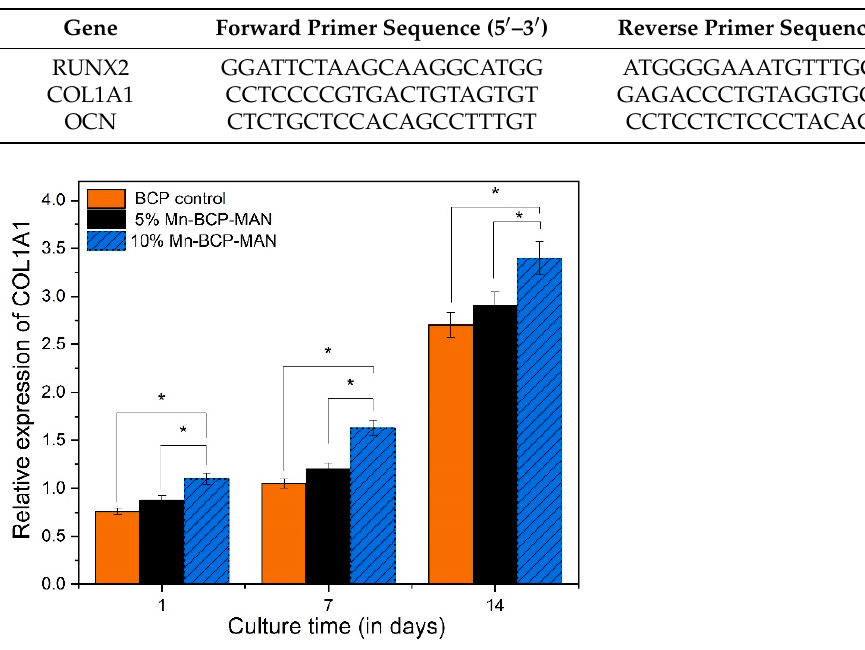
Figure 10. Relative expression of collagen 1; * denotes p < 0.05.